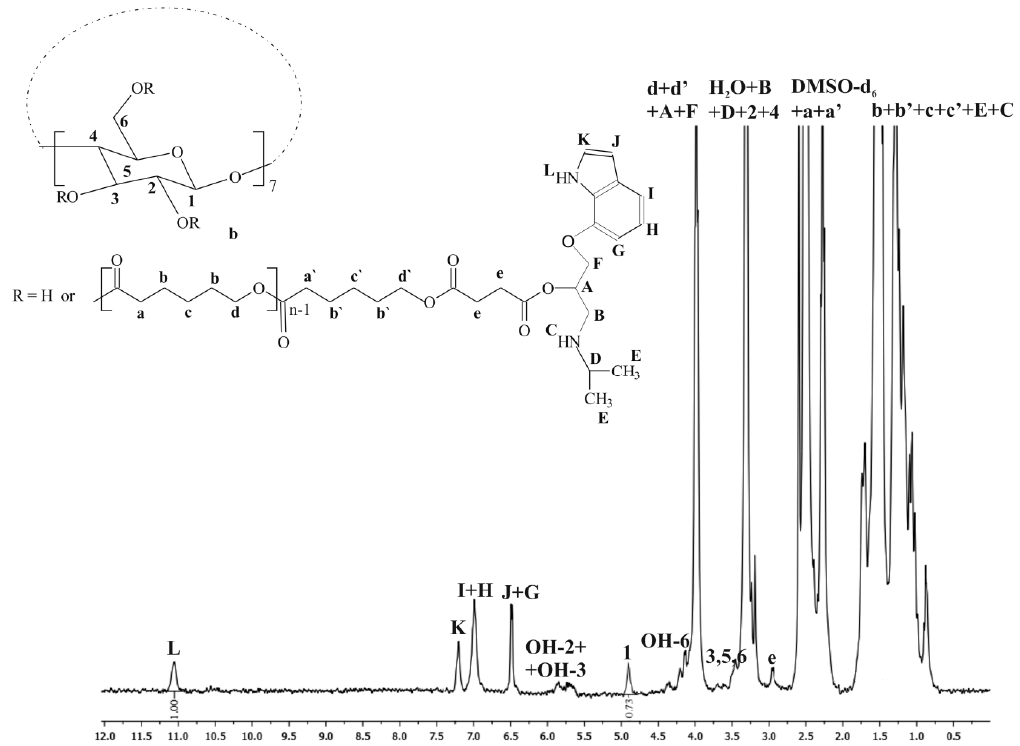
Figure 9. 1 H NMR spectrum of the β -CD / PCL100 / PDL conjugate.